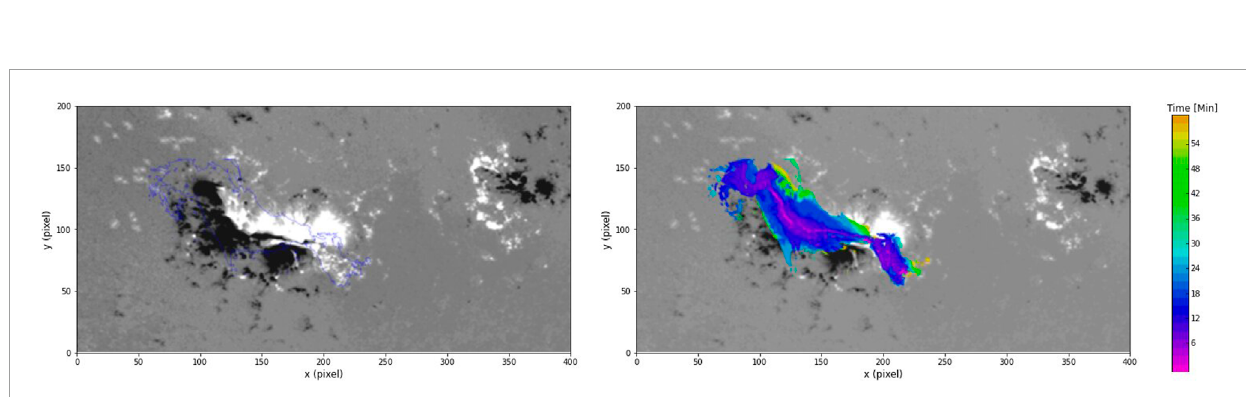
occurs higher in the solar atmosphere in the corona. Though vector magnetic field observations are not available for the corona as they are for the photosphere, modeling of the coronal magnetic field provides an effective approach to study the state of the field during solar flare events and potentially find such